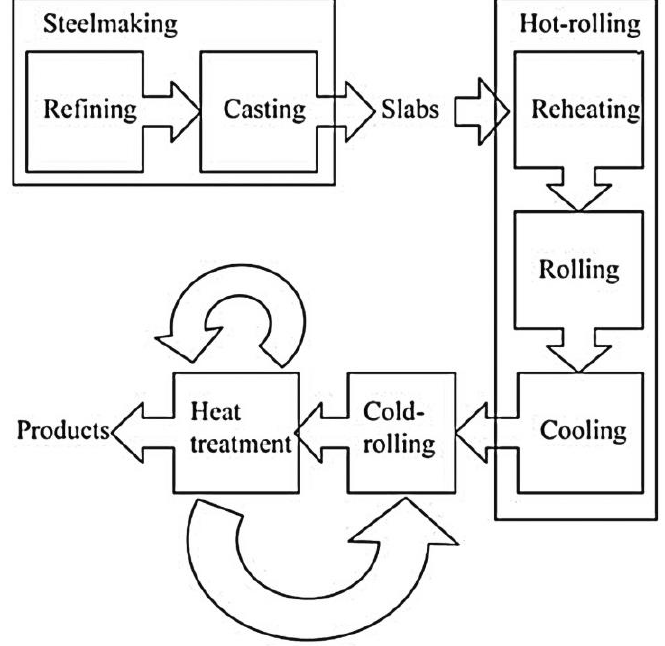
Figure 1. Schematic of conventional slab to finish coil production process (reproduced from [4], with permission from the authors, 2013).